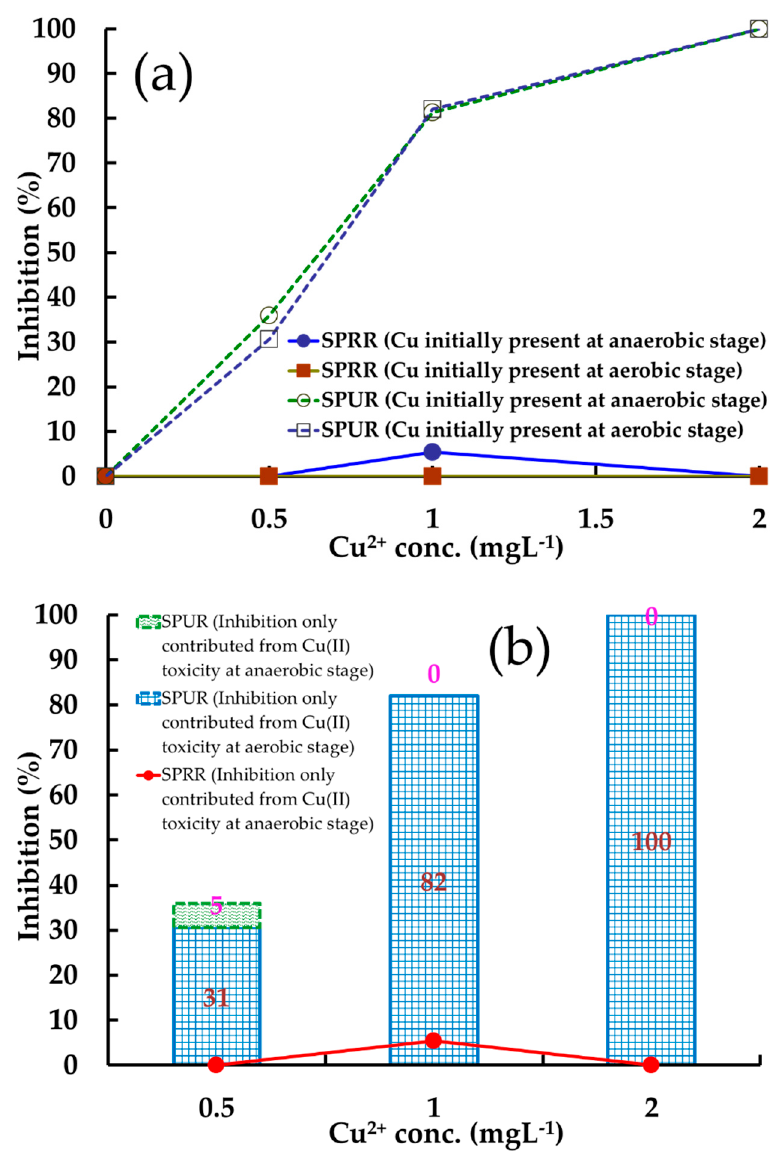
Figure 4. Cu(II) inhibition of phosphorus metabolisms at 20 °C. ( a ) Cu(II) appearance at different stages; ( b ) inhibition contributions from different stages.